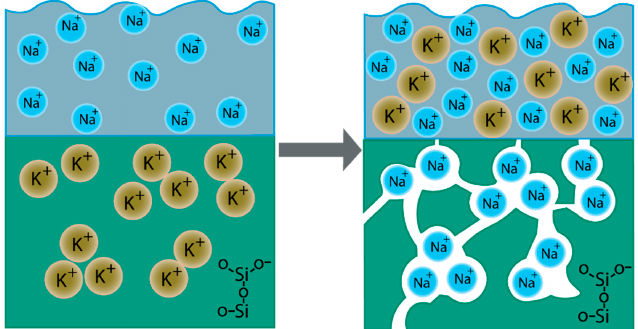
Figure 1. Ion exchange process between KFeSi glass and NaNO 3 melt.